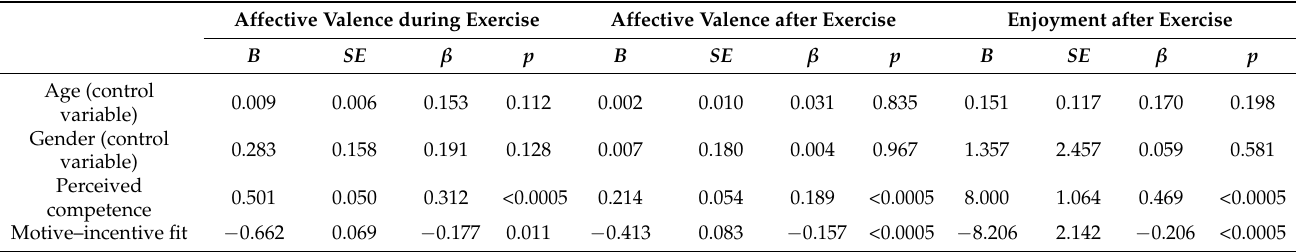
Table 3. Within person-associations between perceived competence, motive–incentive fit and affective well-being during and after exercise sessions ( n =